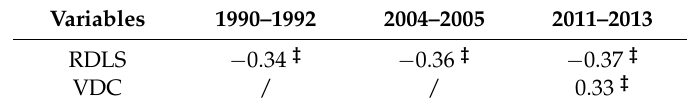
Table 3. Correlation between the village-level mortality rate and topographic factors in